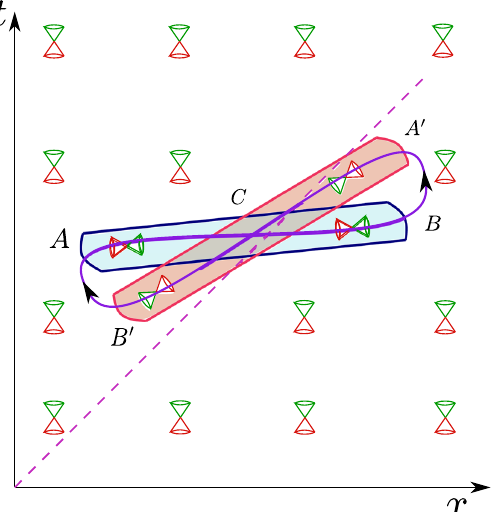
Fig. 4 We represent here two warp drives in 1 + 1 dimensions and in such a configuration that they appear to allow for the formation of CTCs. The purple curve represents a generic CTC on this background. The problem with this 1 + 1 configuration is that the metric in the region where the two warp-drive bubbles cross is ill-defined. As described in the text the simplest geometry with CTCs is either one with a S 1 × R topology or with topology R D + 1 in D + 1 dimensions, with D > 1. In this latter case, we just need to engineer the two warp drives bubbles in different parallel planes to avoid the crossing